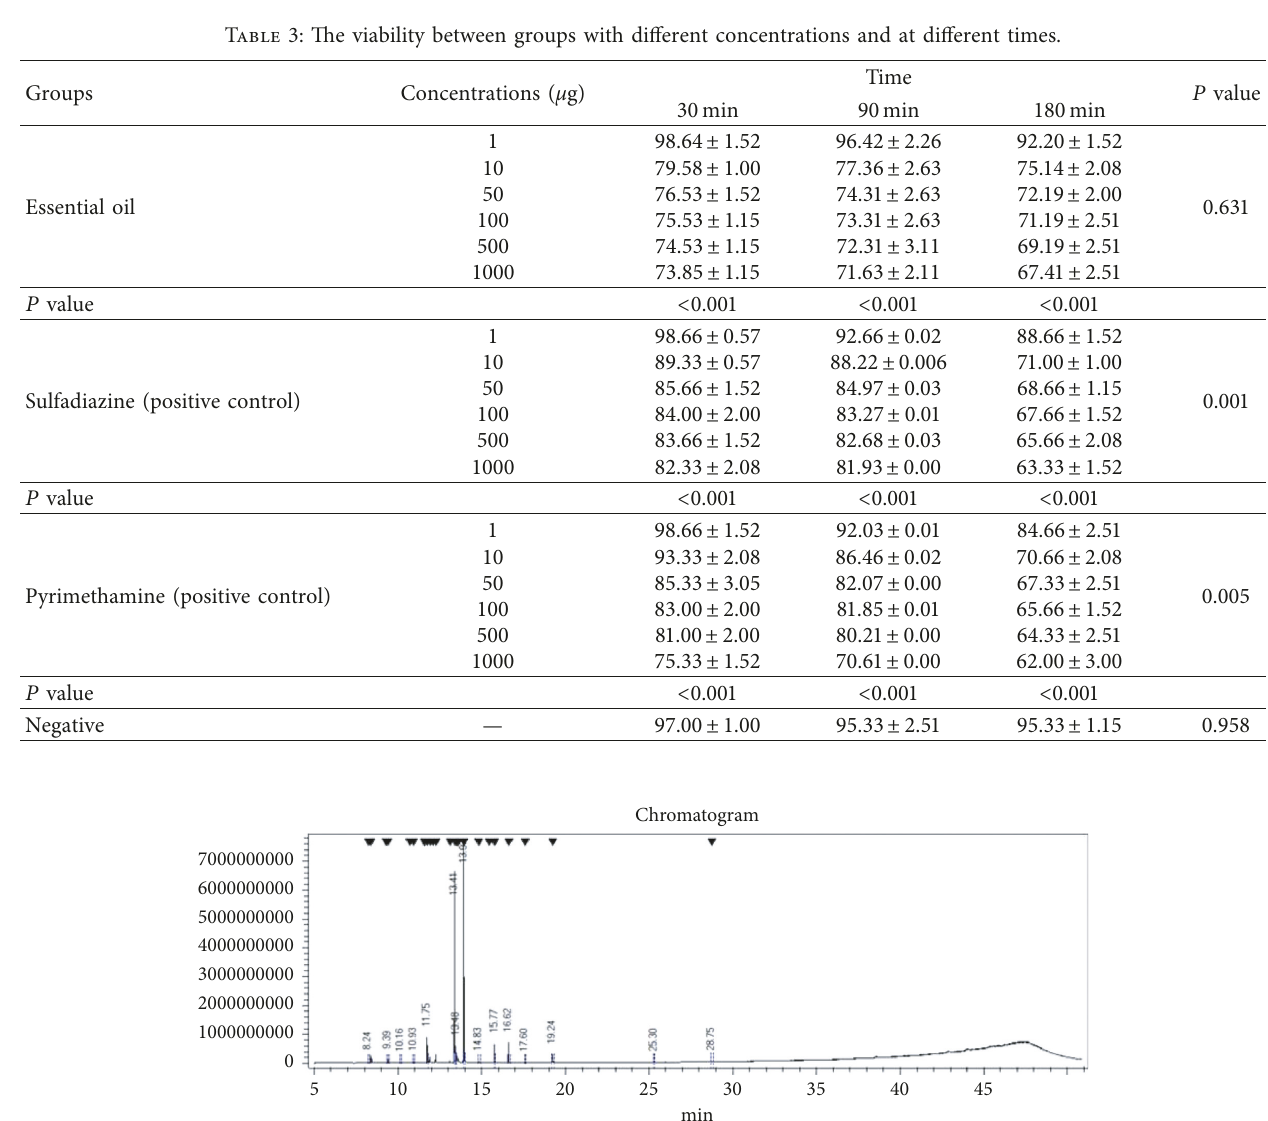
Figure 2: Typical GC-MS total ion current (TIC)